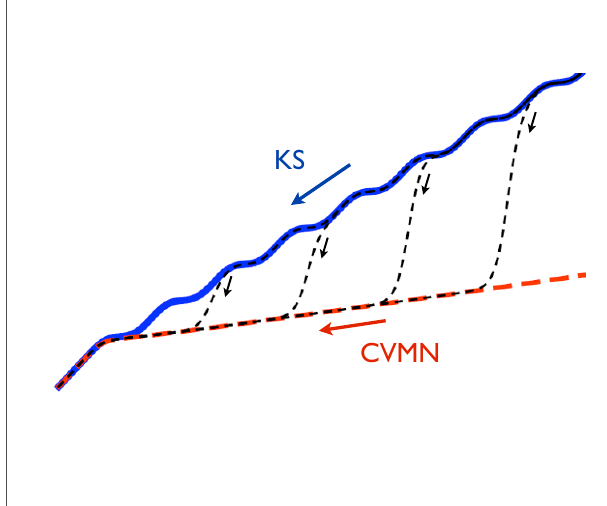
Figure 3 . Illustrative depiction of the RG (cid:13)ows of the (cid:12)eld theories discussed in the paper: the KS solution (blue, continuous line), the CVMN solution (red, long-dashed line), and a few examples of the baryonic branch solutions for di(cid:11)erent values of q (black, short-dashed line).